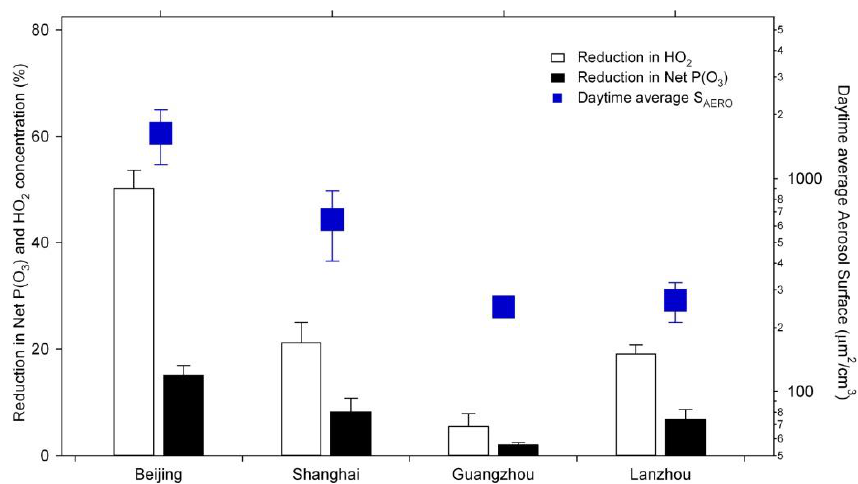
from 0.02 to 0.4 during 2